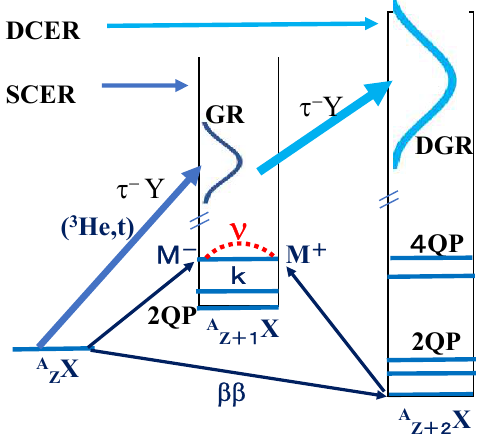
Figure 1. Schematic diagram for the 0 νββ DBD transition of A SCER: A X → A X. DCER: A X → A X. QP: quasi-particle state. GR: giant resonance. DGR: Z Z Z + 2 Z + 1